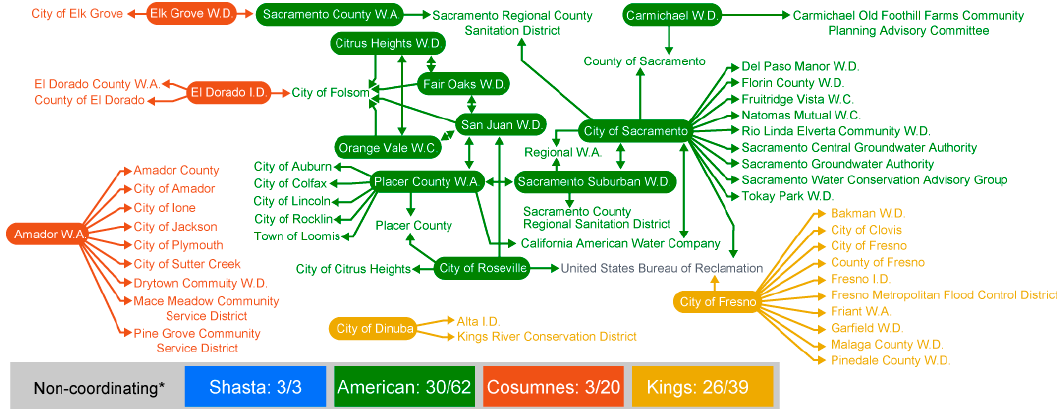
Figure 4. Coordination network by watershed. Non-coordinating organizations (those that are mentioned in a plan, but not as direct coordinators) are listed as a fraction of all organizations mentioned for each watershed. “I.D.” = Irrigation District; “W.D.” = Water District; “W.A.” = Water Agency.